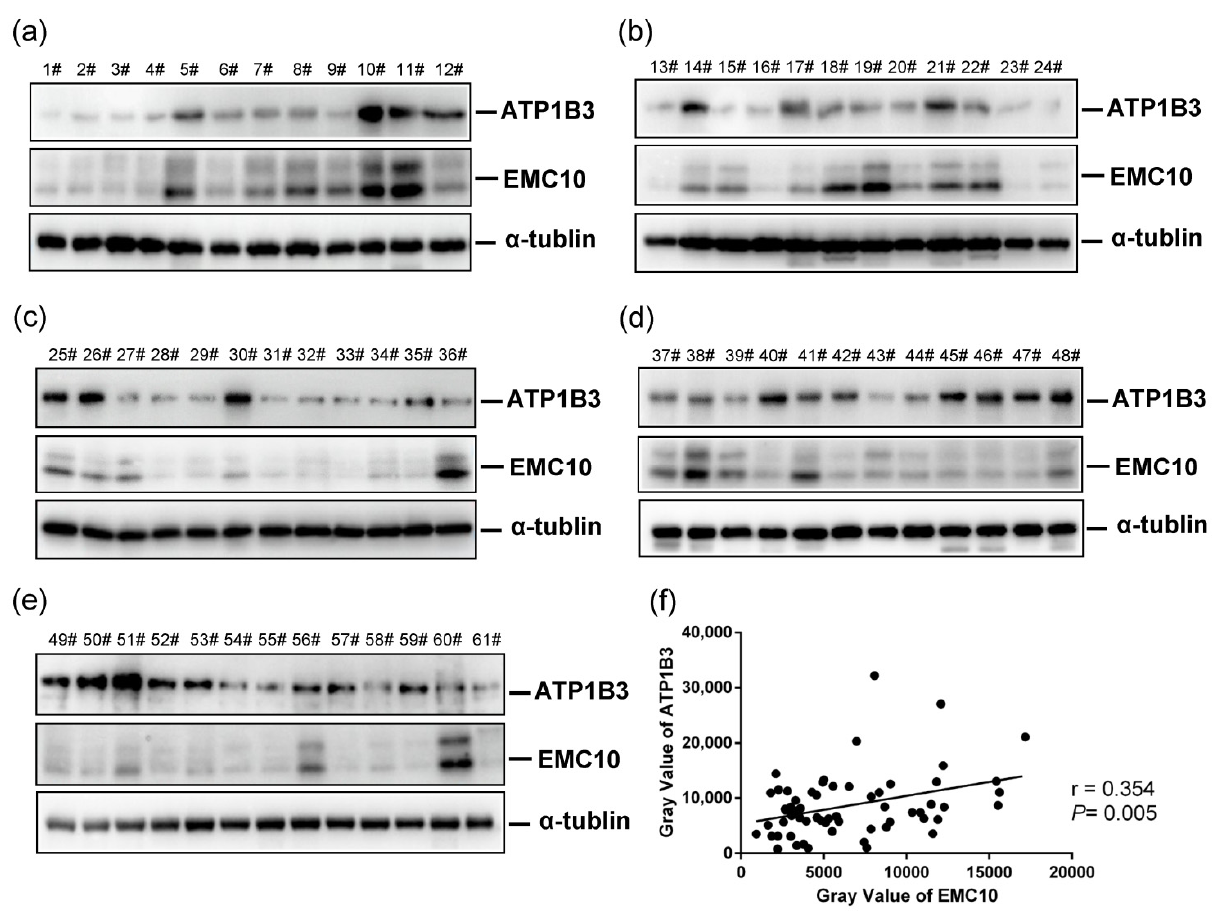
Figure 5. The protein levels of EMC10 and ATP1B3 in human spermatozoa. ( a – e ) EMC10 and ATP1B3 protein expression were determined by Western blotting in 61 human sperm samples. ( f ) Based on the Western blotting results shown in ( a – e ), gray values of EMC10 and ATP1B3 were evaluated using ImageJ software version1.8.0 (National Institutes of Health, Bethesda, MD, USA). Correlation analysis of the levels of EMC10 and ATP1B3 protein in these samples were performed using Spearman’s analysis.